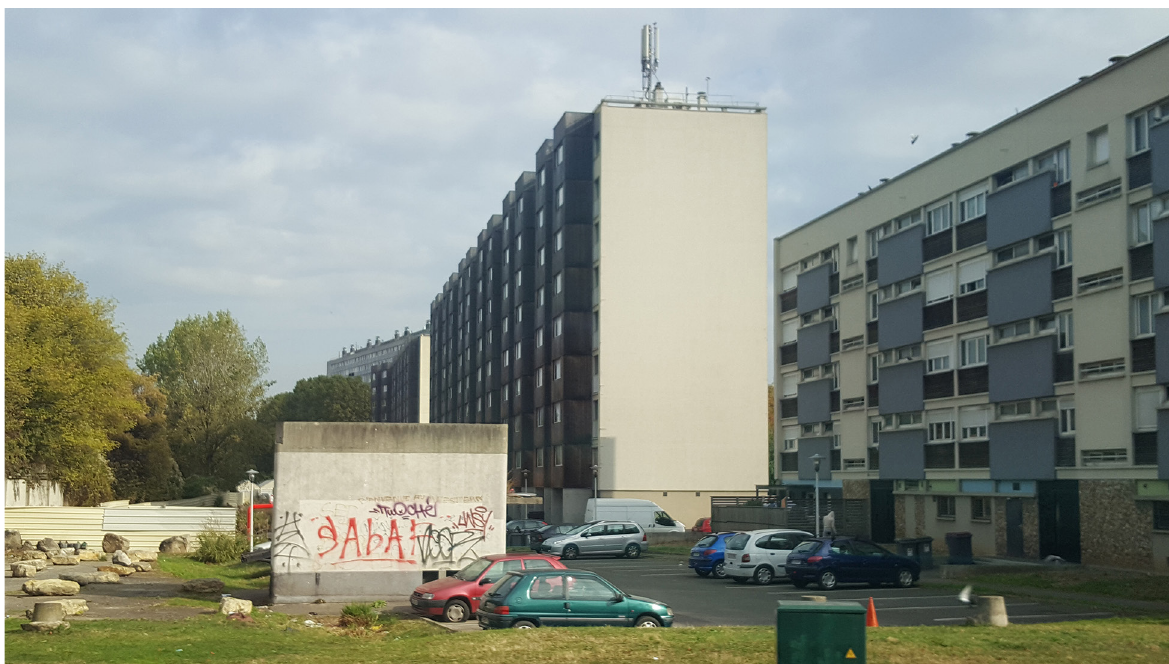
Fig. 1. High rise blocks in Bondy-Nord (eastern rim of Paris). Photo by Florian Weber (2016).